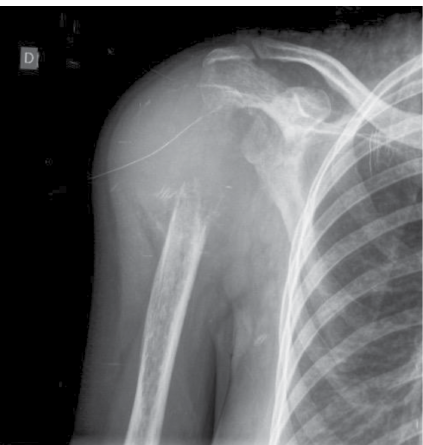
Figure 1: Right arm radiographic. There is a lytic bone lesion on her shoulder with infiltration of local soft tissue. Core biopsies were performed from this site.